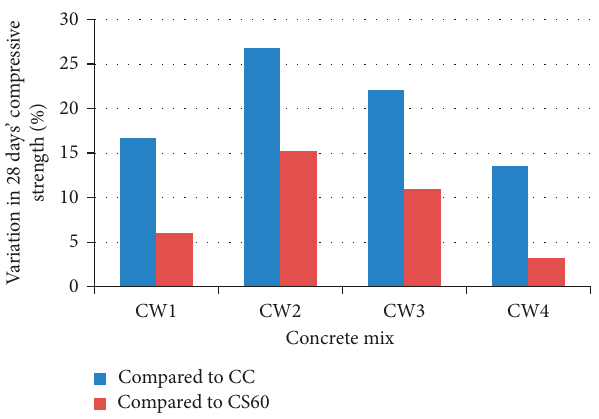
Figure 3: Variation in the compressive strength of the Type B mixes.